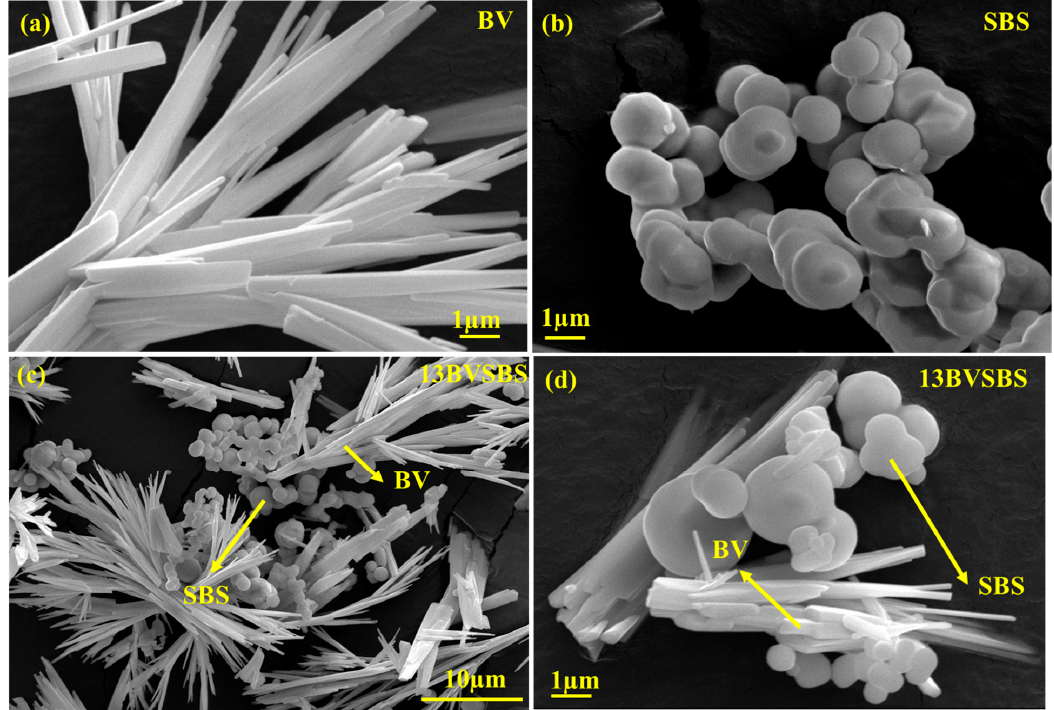
Figure 3. SEM images of ( a ) BV, ( b ) SBS, and ( c , d ) 13BVSBS photocatalyst with different magnification.